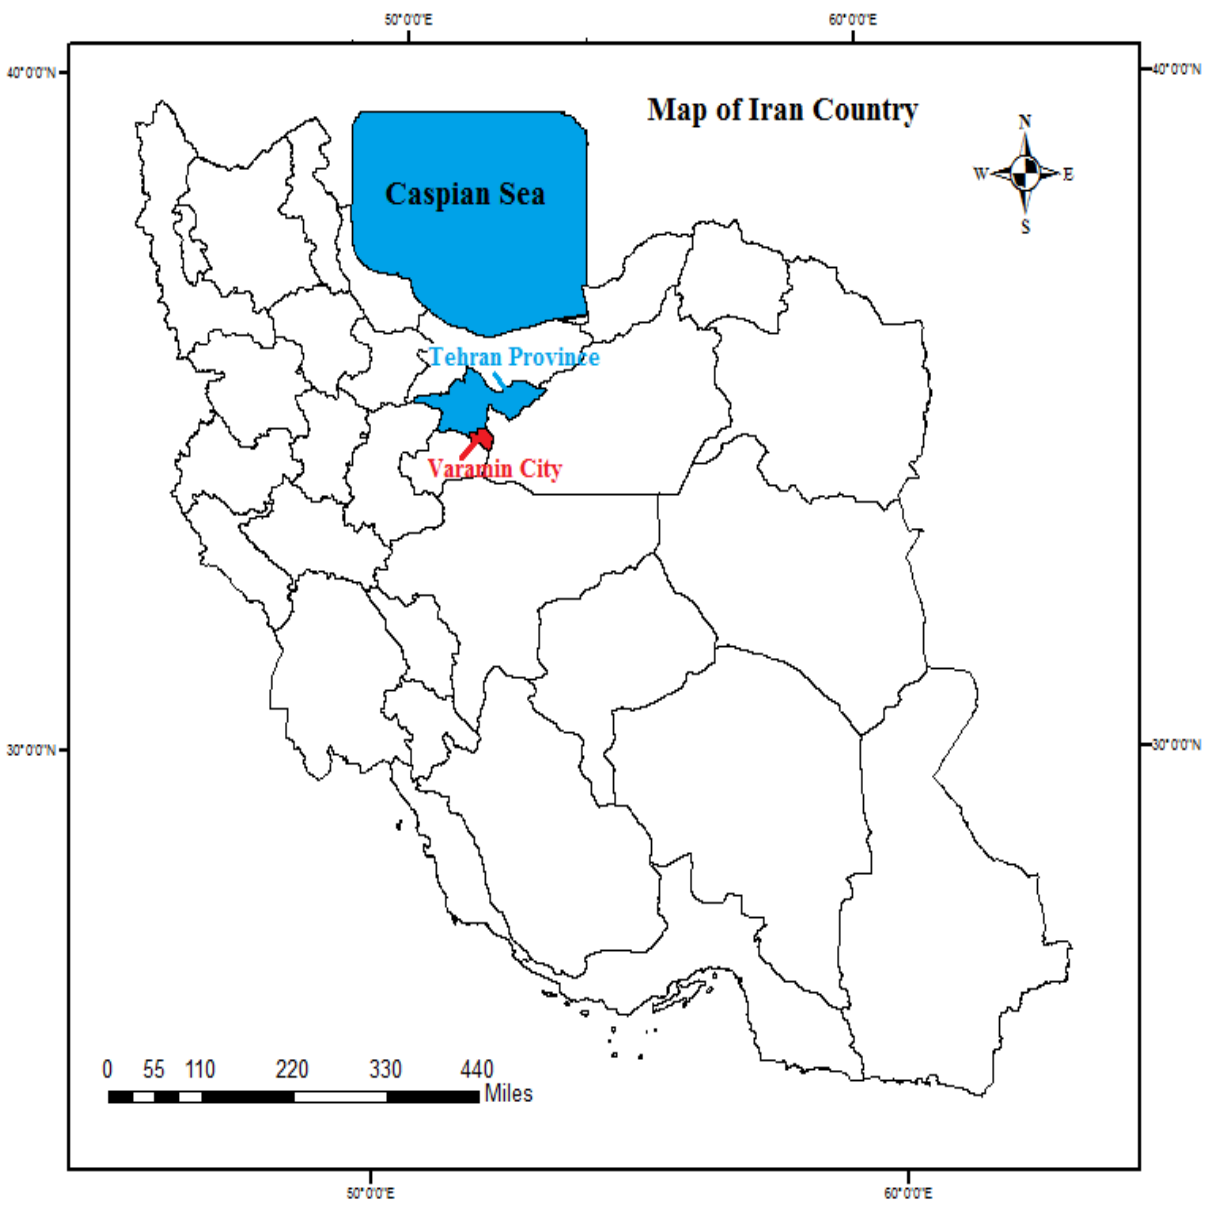
Figure 1. Location of the study area: location of Varamin city in the country (The blue color is Tehran province and the red color is Varamin city).